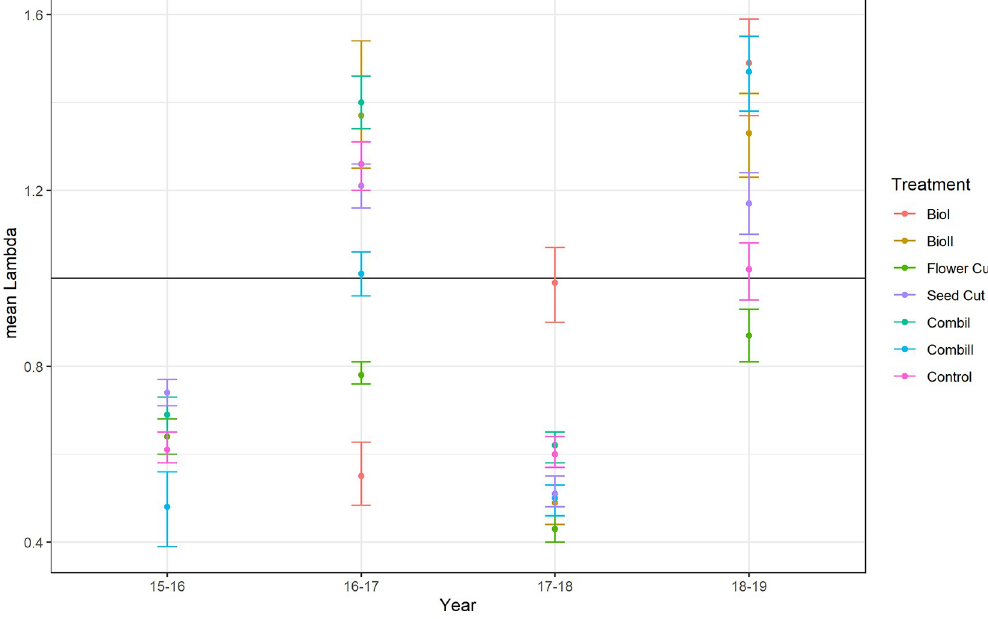
Fig 5. Population growth rates for treatments according to years. Shown are the means ± 95% CI. Treatments did not differ significantly. Constant population is marked with the line λ = 1.